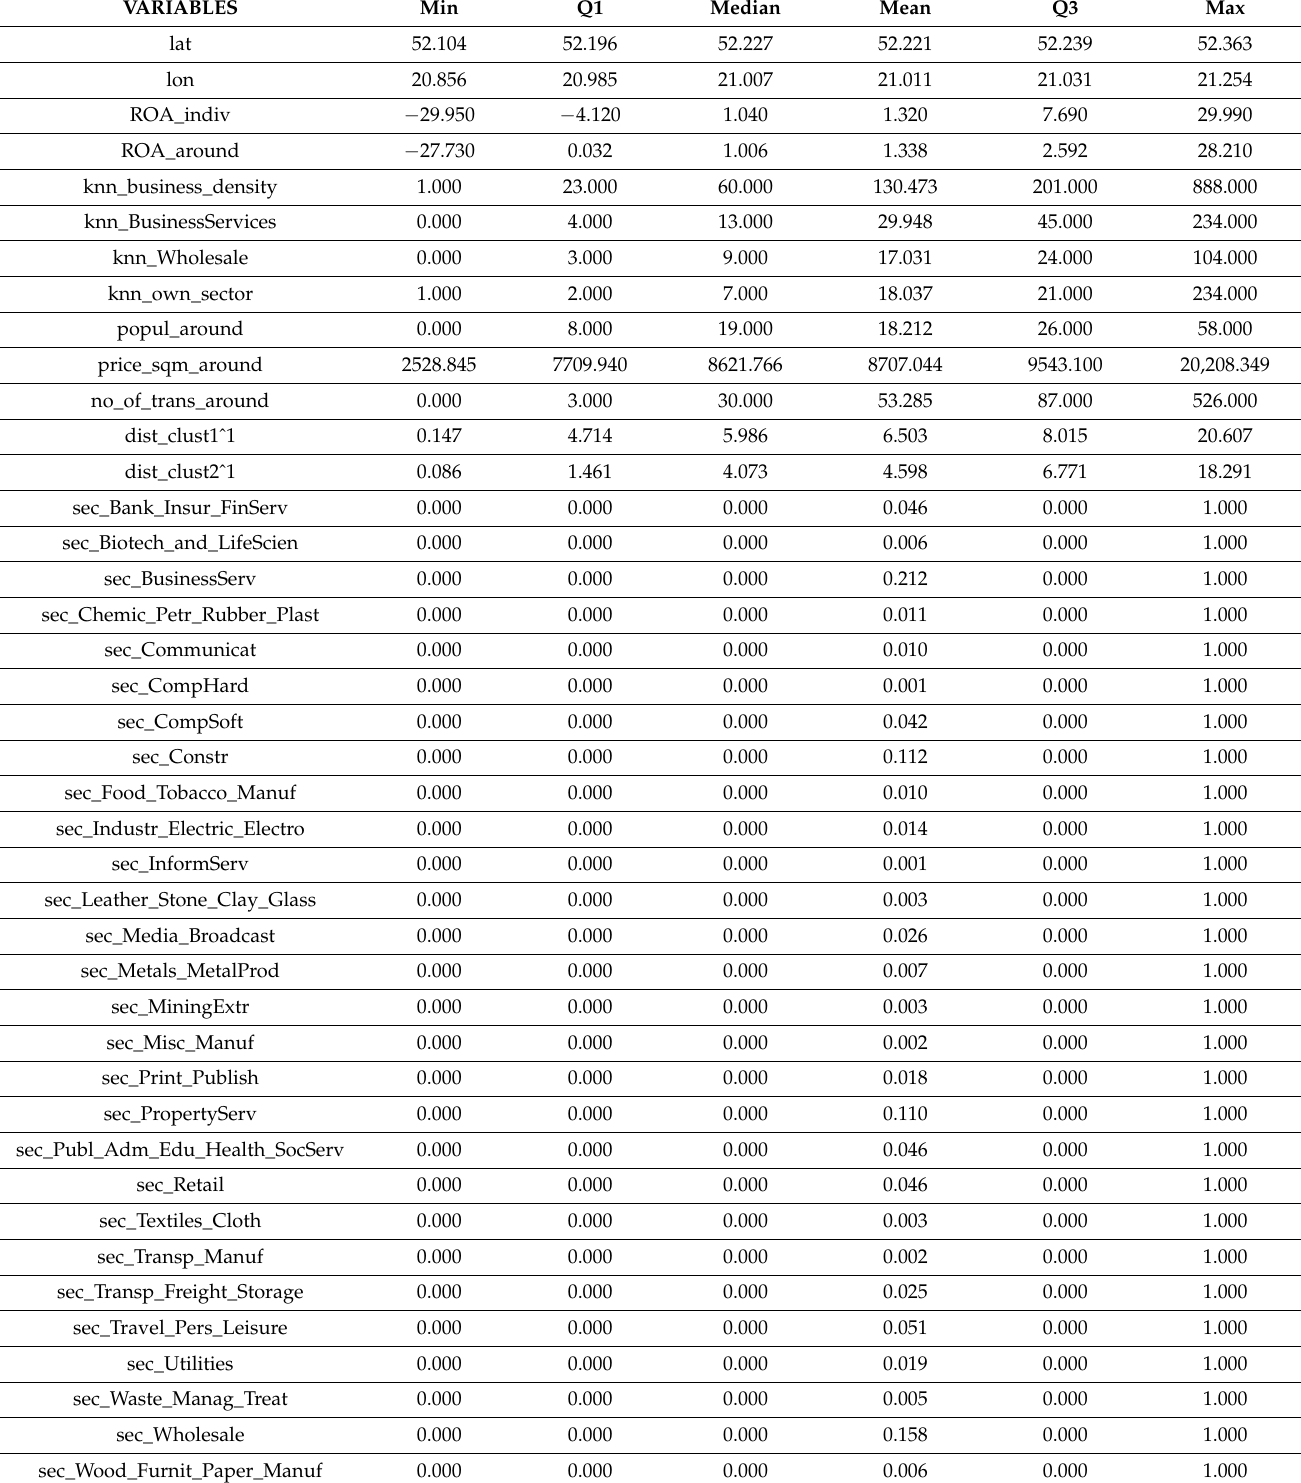
Table A1. Descriptive statistics of the analysed